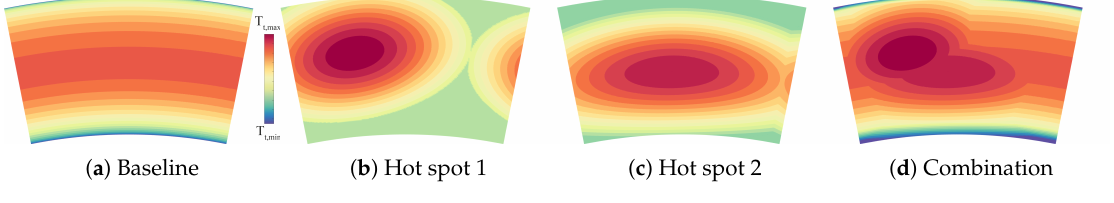
Figure 7. Generation of the temperature